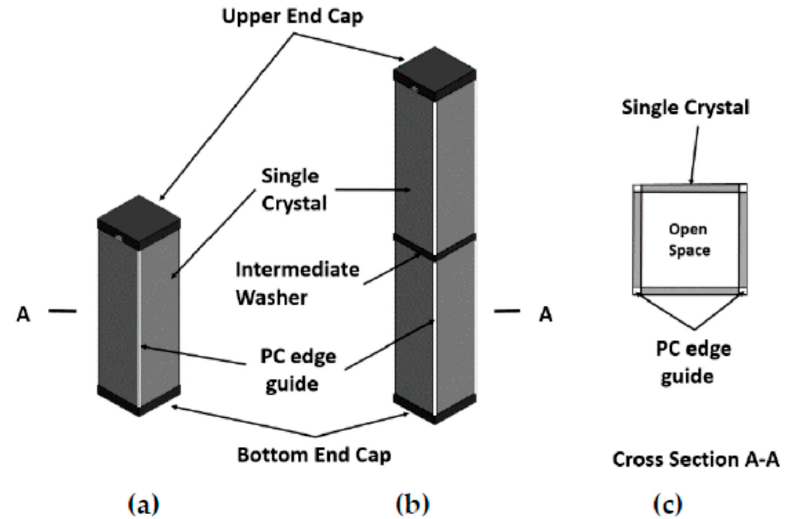
Figure 1. Sketches showing the construction of square-pipe stake actuators of ( a ) single-level and ( b ) 2-level construction. ( c ) A cross-sectional view across the component crystals.